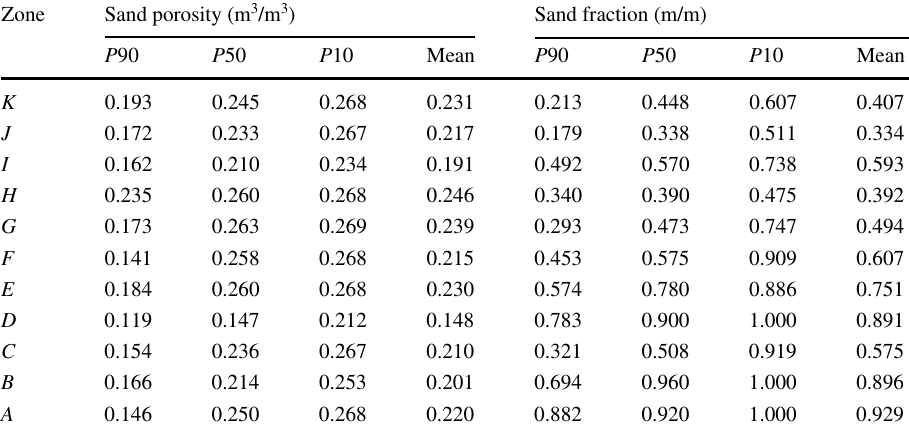
Table 4 Statistics of sand fraction and sand